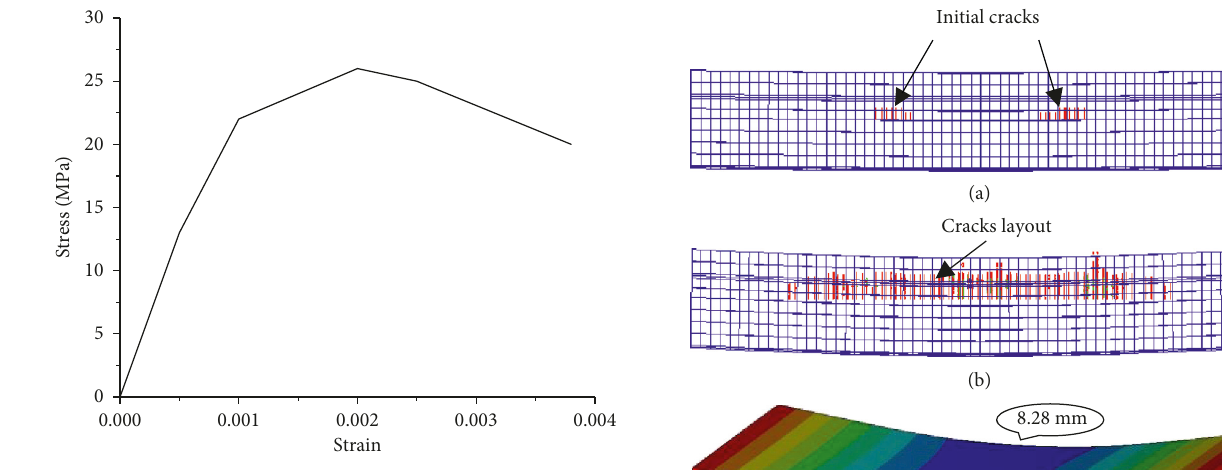
Figure 6: Stress-strain relationship of recycled aggregate concrete.